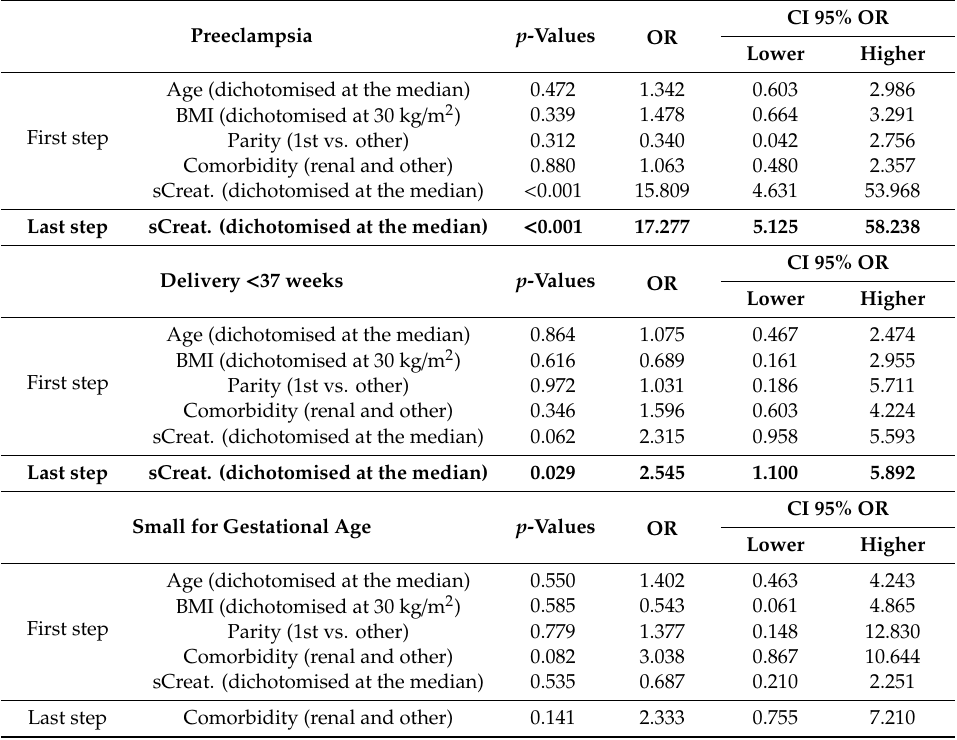
Table 6. Multivariate analysis of di ff erent outcomes: cases with creatinine